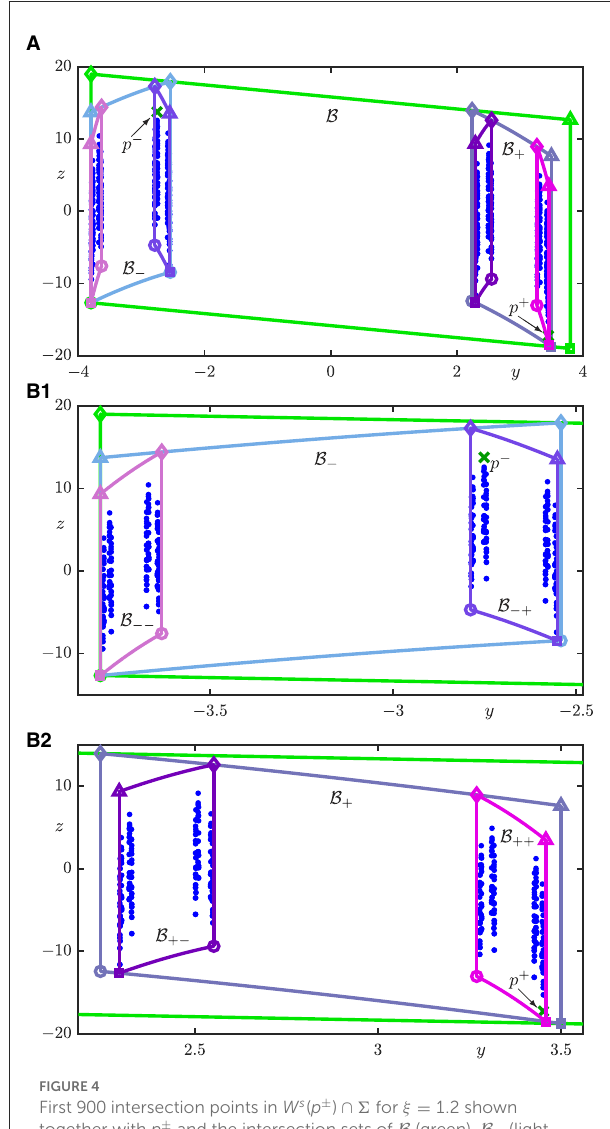
FIGURE4 First 900 intersection points in W s ( p ± ) ∩ 6 for ξ = 1.2 shown together with p ± and the intersection sets of B (green), B − (light blue), B + (dark blue), B −− (light magenta), B −+ (light purple), B +− (purple), and B ++ (magenta). (A) shows all of 6 ∩ B , and (B1, B2)